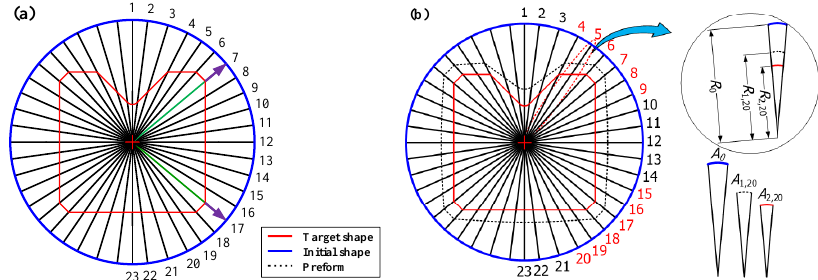
Figure 5. ( a ) Initial and target shapes of the cross-roller guide and ( b ) preform of the cross-roller guide.